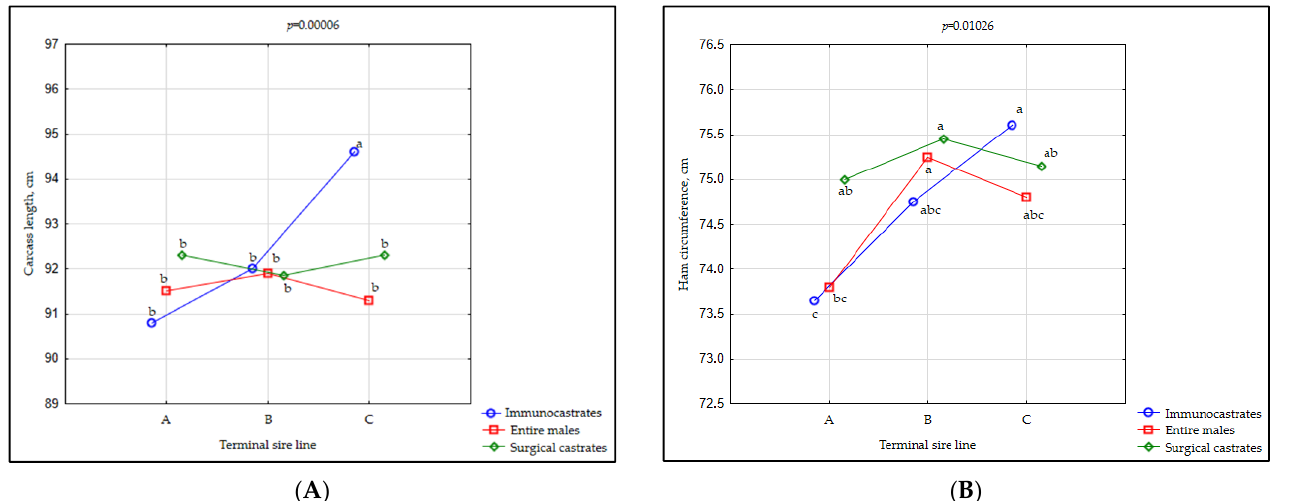
Figure 1. ( A ) Terminal sire line (TSL) by male category (MC) interaction for carcass length ( os pubis —1st rib) and ham circumference ( B ). Terminal sire line A = Pietrain × Large White; Terminal sire line B = pure Pietrain; Terminal sire line C= Pietrain × Duroc × Large White. Significant differences ( p < 0.05) between groups are denoted by different lowercase letters (a, b, c).